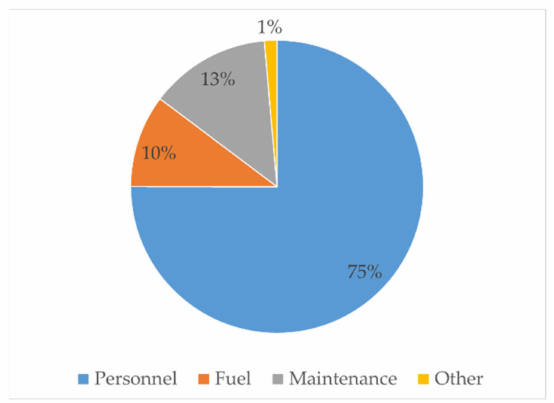
Figure 2. Distribution of expenses—1 m 3 vacutug.